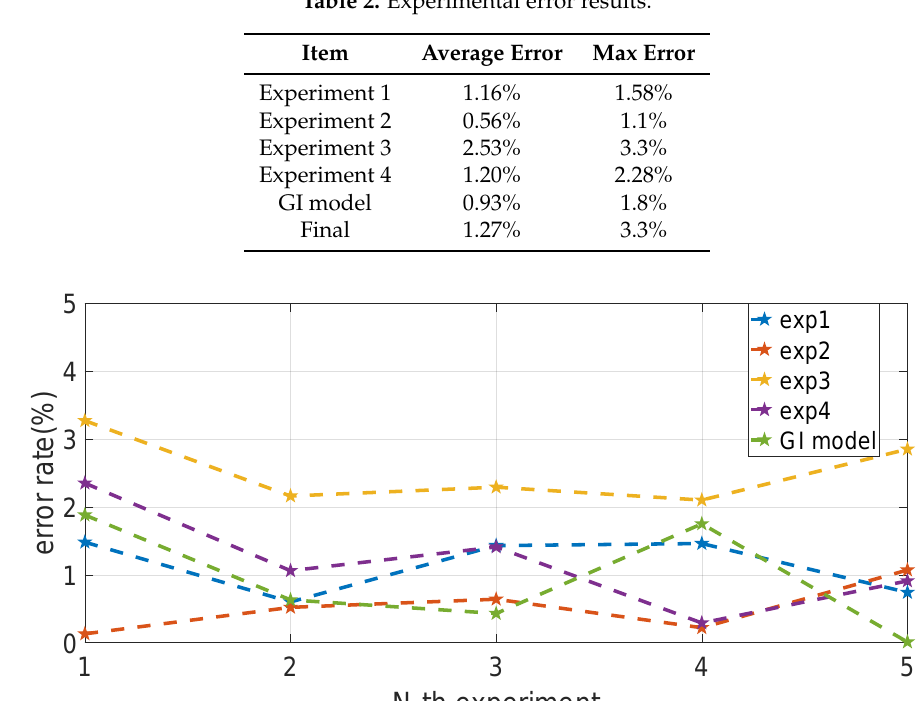
Figure 13. Experimental error results. The maximum distance error is 3.3%, and the final average is 1.27%, which is acceptable for further endoscopy insertion